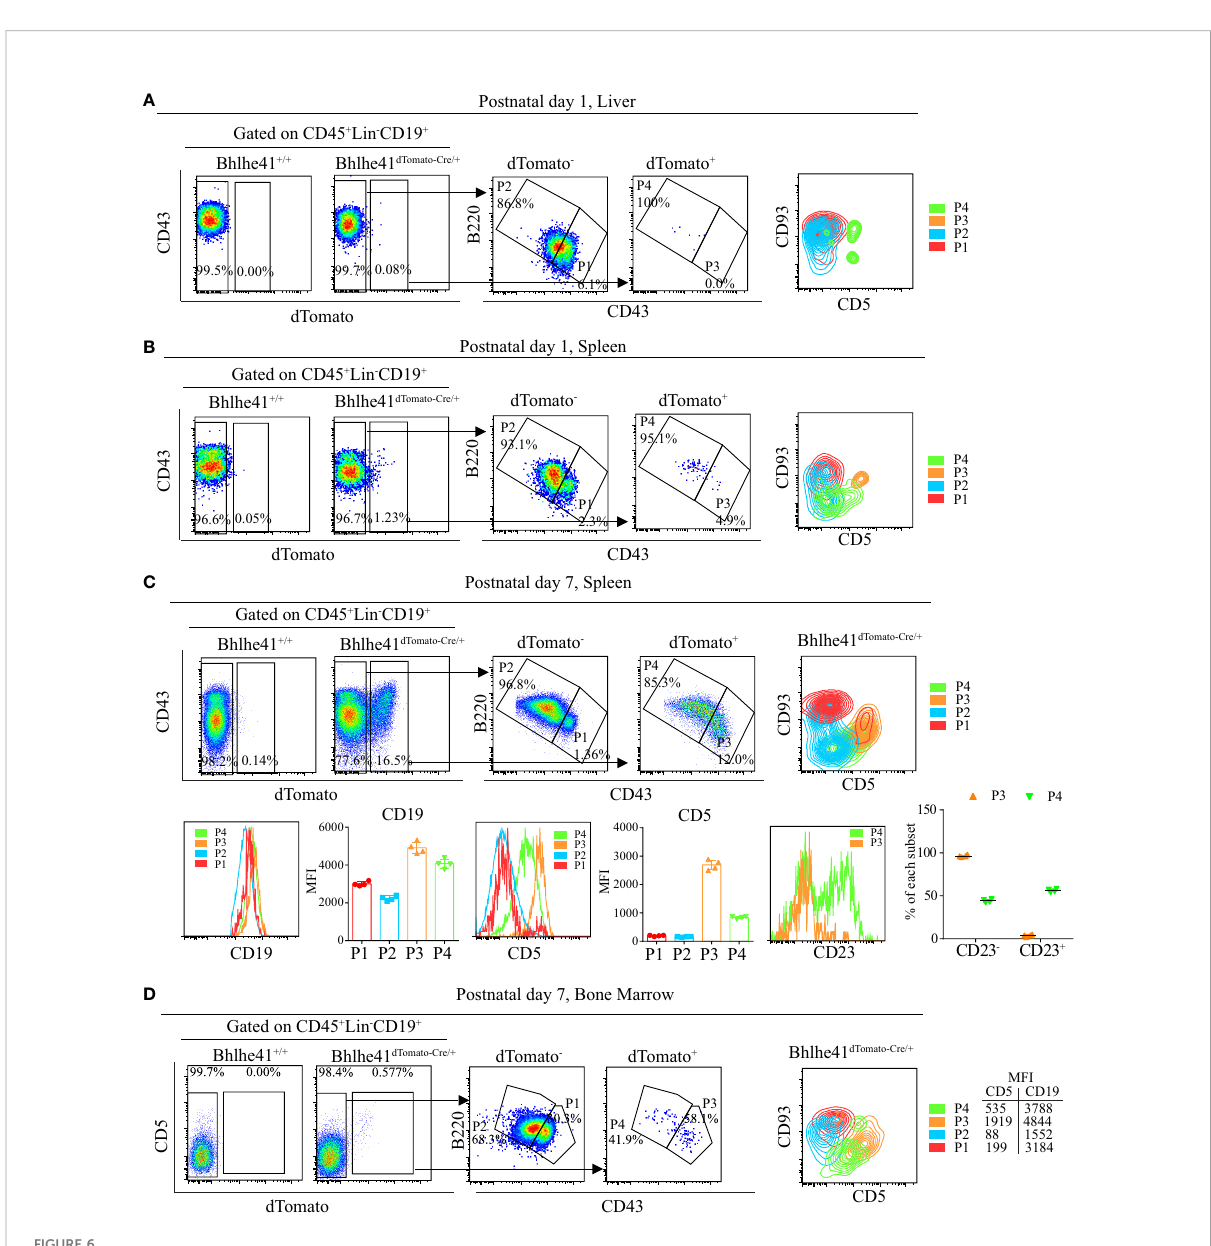
FIGURE 6 Characterization of neonatal CD19 + dTomato + B cells using Bhlhe41 dTomato-Cre mice. Flow cytometric analysis of CD19 + dTomato + B cells in (A) liver and (B) spleen from Bhlhe41 dTomato-Cre/+ mice at postnatal day 1, and (C) spleen and (D) bone marrow from Bhlhe41 dTomato-Cre/+ mice at postnatal day 7. MFI, mean fl uorescence